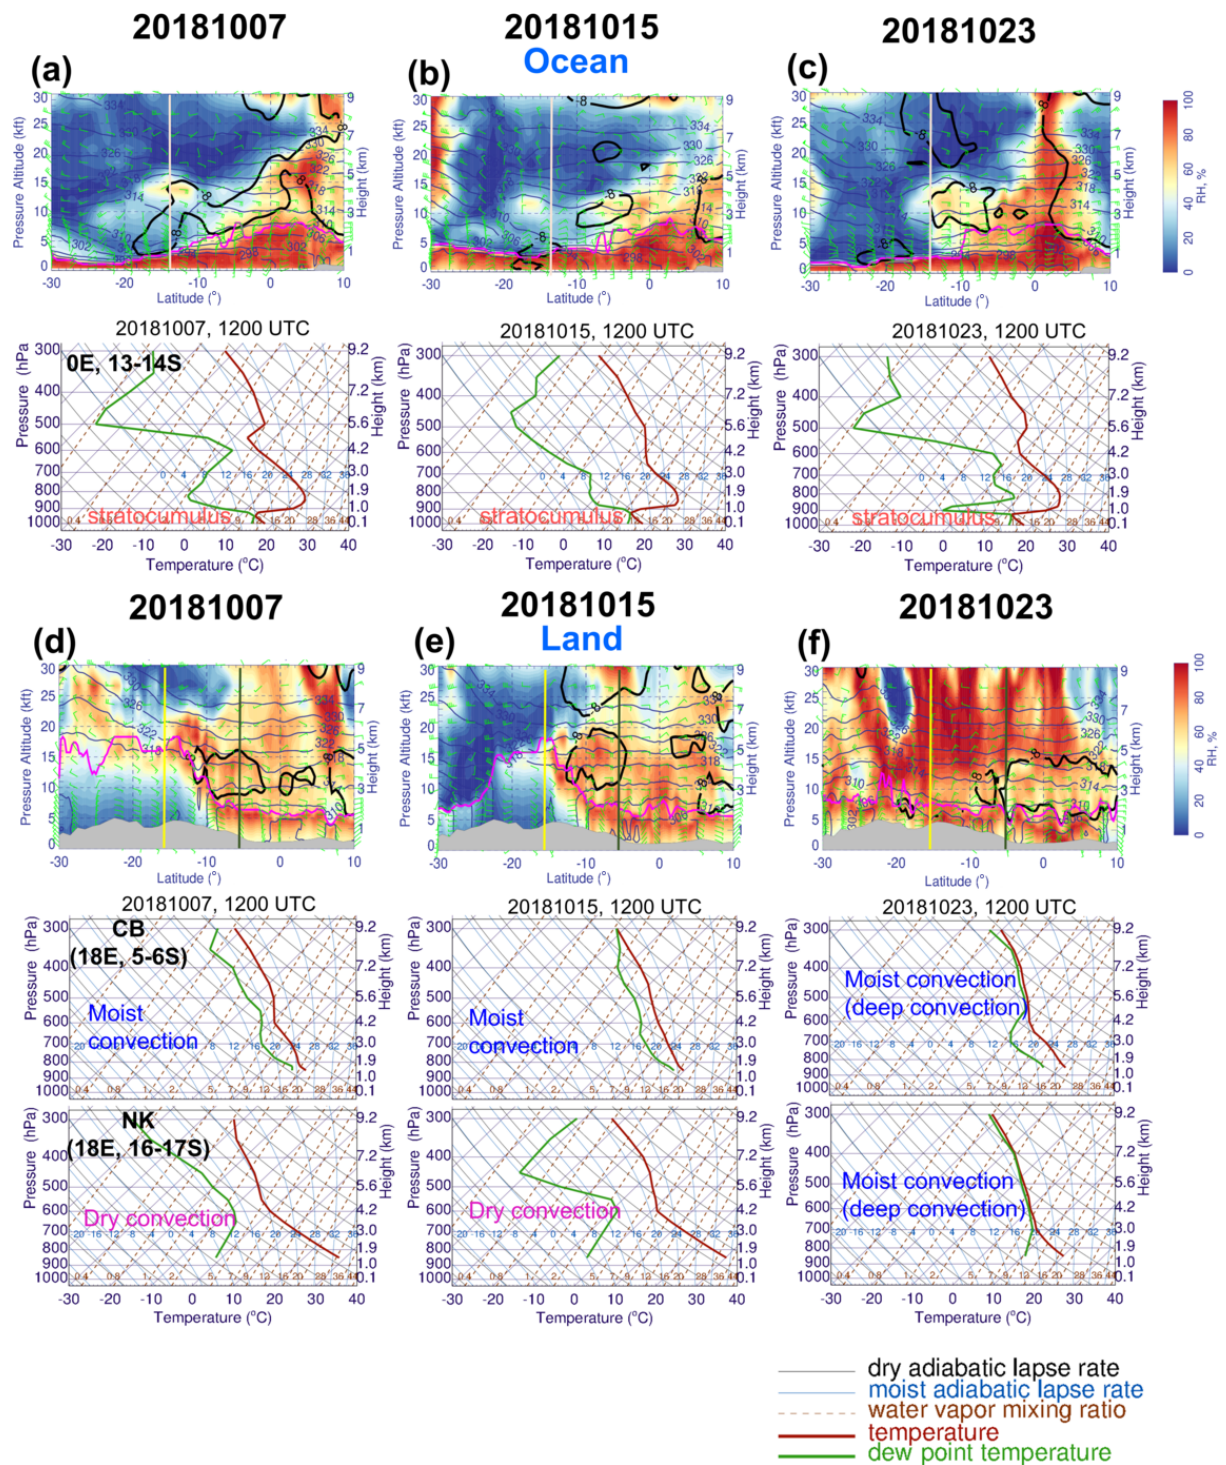
Figure 15. (a–c) Ocean, with a latitudinal cross section of RH (shading; %), horizontal winds (wind barbs; green, ms − 1 ), potential tem- perature ( θ ; navy; K), and BLH (magenta; m) at 0 ◦ E (top) and Skew-T log-P diagram averaged over 0 ◦ E and 13–14 ◦ S (bottom, from the left) at 12:00UTC on 7, 15, and 23 October 2018. Bold black contours are zonal wind ( − 8ms − 1 ). (d–f) Land, which is the same as in panels (a) – (c) , except for the cross section at 18 ◦ E and Skew-T log-P diagram averaged over 18 ◦ E and 5–6 ◦ S (CB is the Congo basin) and 18 ◦ E and 16–17 ◦ S (NK is the Namibian–Kalahari dryland). The gray-filled area represents the topography. The vertical lines in the cross-sectioned plots refer to the latitude we